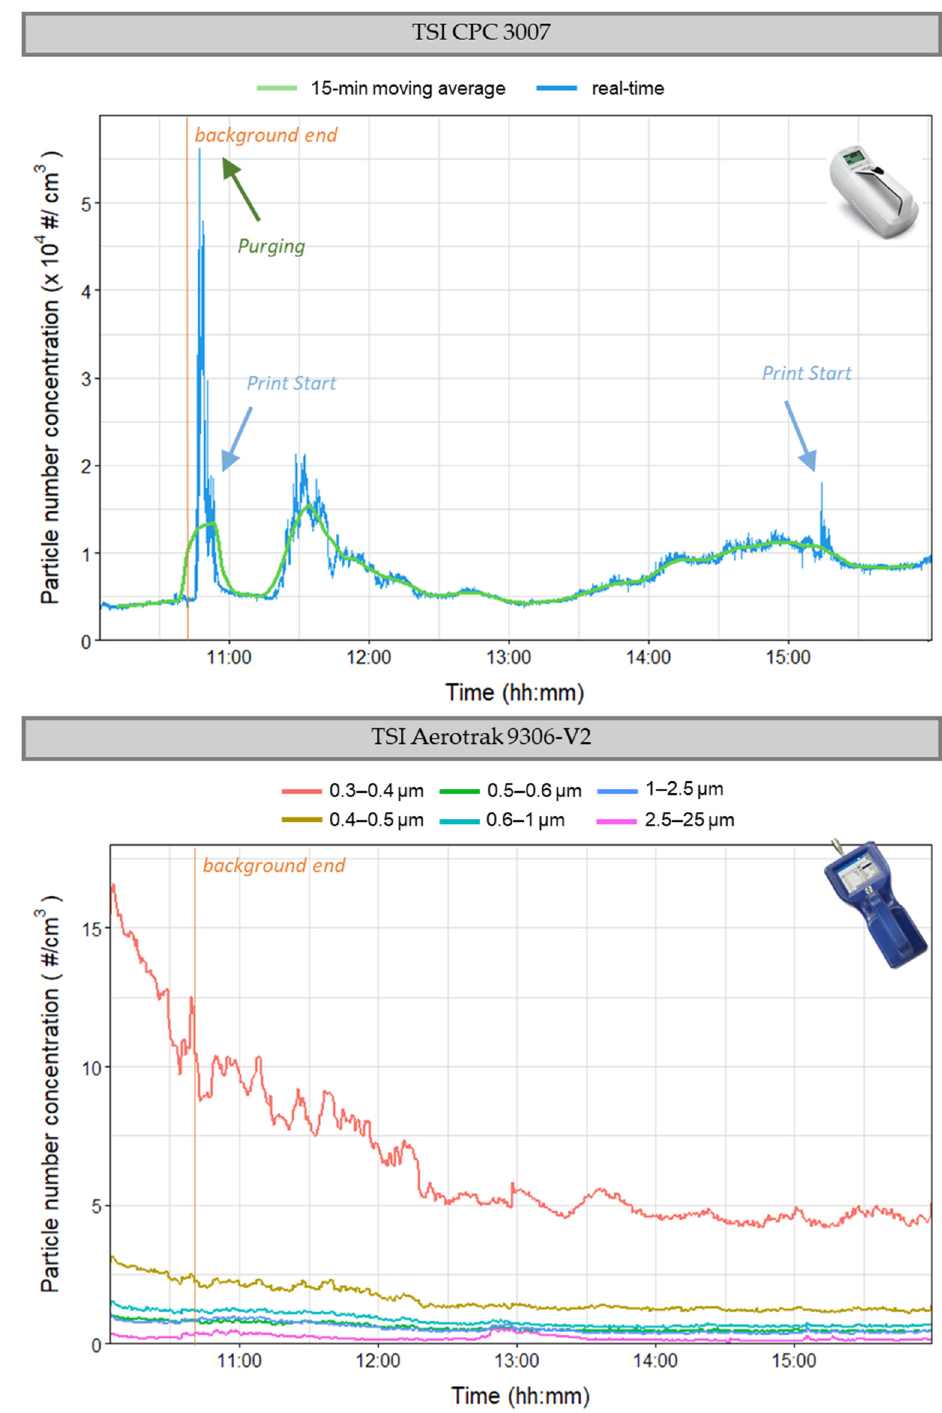
Figure 4. Particle concentrations for Case 3a.